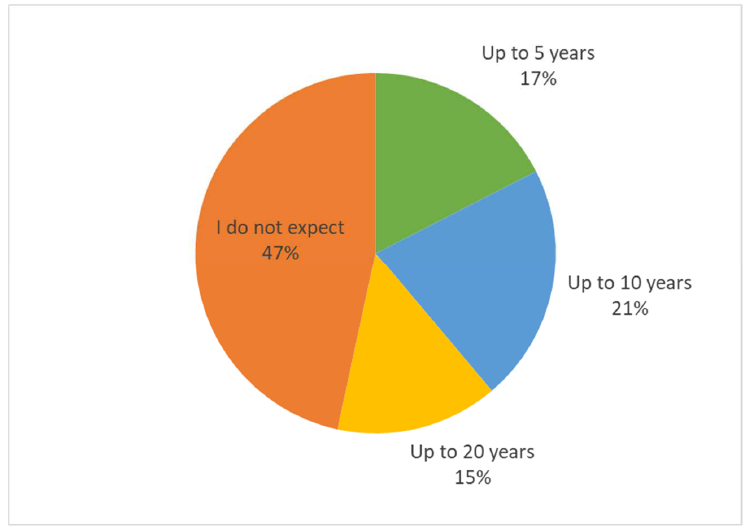
Figure 13. When do you expect the AI threat to become real? N = 103.